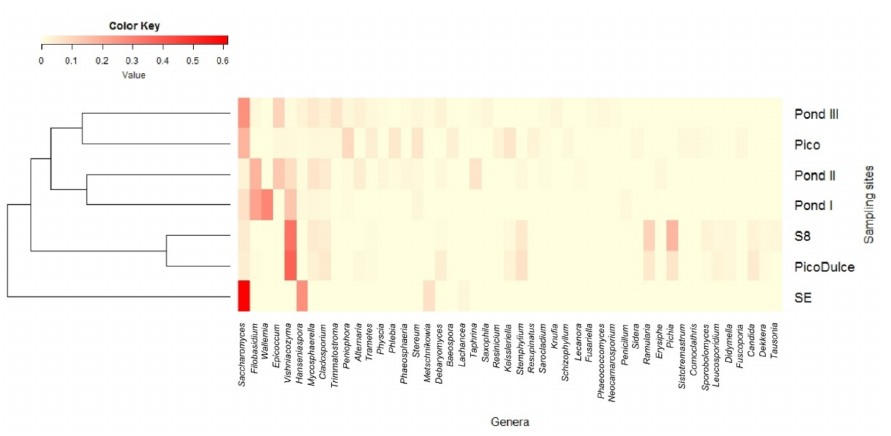
Figure 3. Heatmap showing the distribution of the most abundant genera along the sampling sites. The color represents the abundance of genera; the closer to red, the higher the abundance, and the closer to yellow, the lower the abundance. Clustering was performed based on the Bray–Curtis dissimilarity. SE, Santa